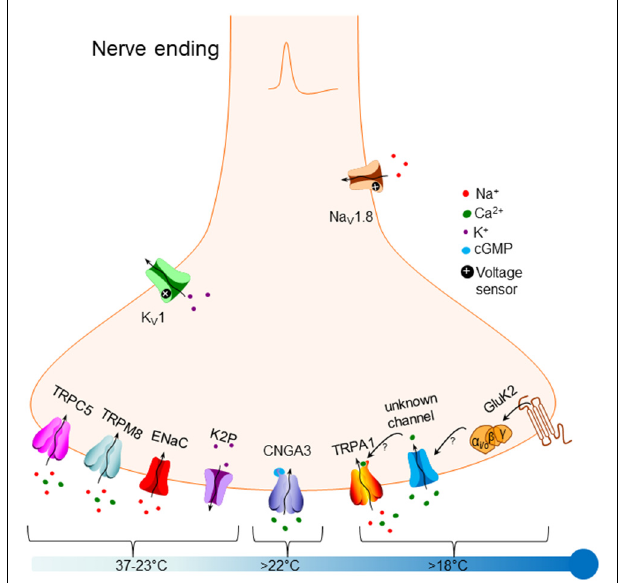
FIGURE 1 | Overview of molecular mechanisms that have been proposed to underlie responses to cold in primary somatosensory neurons. Bottom left: potential sensory mechanisms triggered by mild non-noxious cooling, down to around 23 ◦ C, include TRPC5 [‘Transient Receptor Potential Canonical 5 (TRPC5) ” section], TRPM8 [“Transient Receptor Potential Melastatin 8 (TRPM8)” section], ENaC channels [“Epithelial Sodium Channels (ENaC)” section] and members of the K2P two-pore potassium channel family [“Two-Pore Domain Potassium Channels (K2P)” section]. Bottom middle: the cyclic nucleotide-gated channel CNGA3 has been proposed to be activated by cold down to 22 ◦ C [“Cyclic Nucleotide-Gated Channel Alpha 3 (CNGA3)” section]. Bottom right: noxious cold below 22 ◦ C has been proposed to activate TRPA1 [“Transient Receptor Potential Ankyrin 1 (TRPA1)” section], possibly via activation of an unknown channel (see arrows]. A recent article proposes that the glutamate receptor GluK2 [“Glutamate Ionotropic Receptor Kainate Type Subunit 2 (GluK2)” section] may trigger cold responses that are G-protein mediated, possibly by modulating an unknown channel (see arrows). Top right: expression of the Nav1.8 sodium channel may allow the cold sensation to continue down to very low temperatures (“Modulation of Cold Responses by Background Potassium Currents” section). Top left: sensory neuronal excitability can be modulated by the activity of members